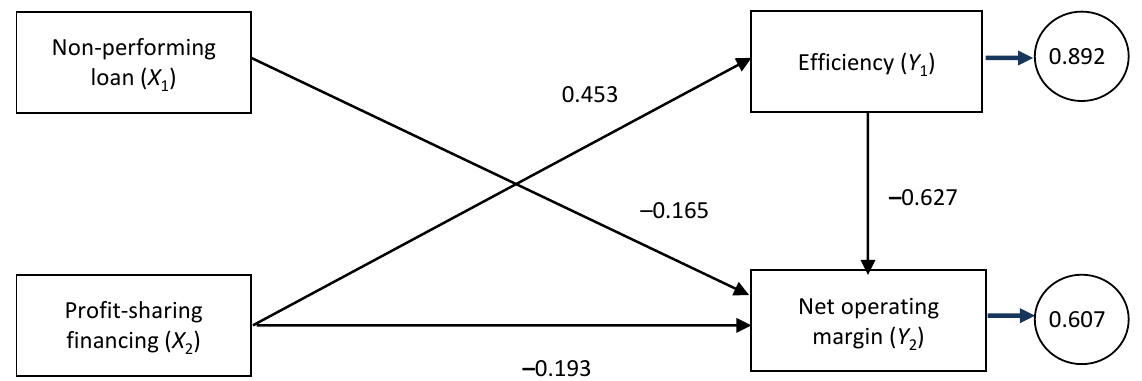
Figure 2. A reduced full model of NOM through